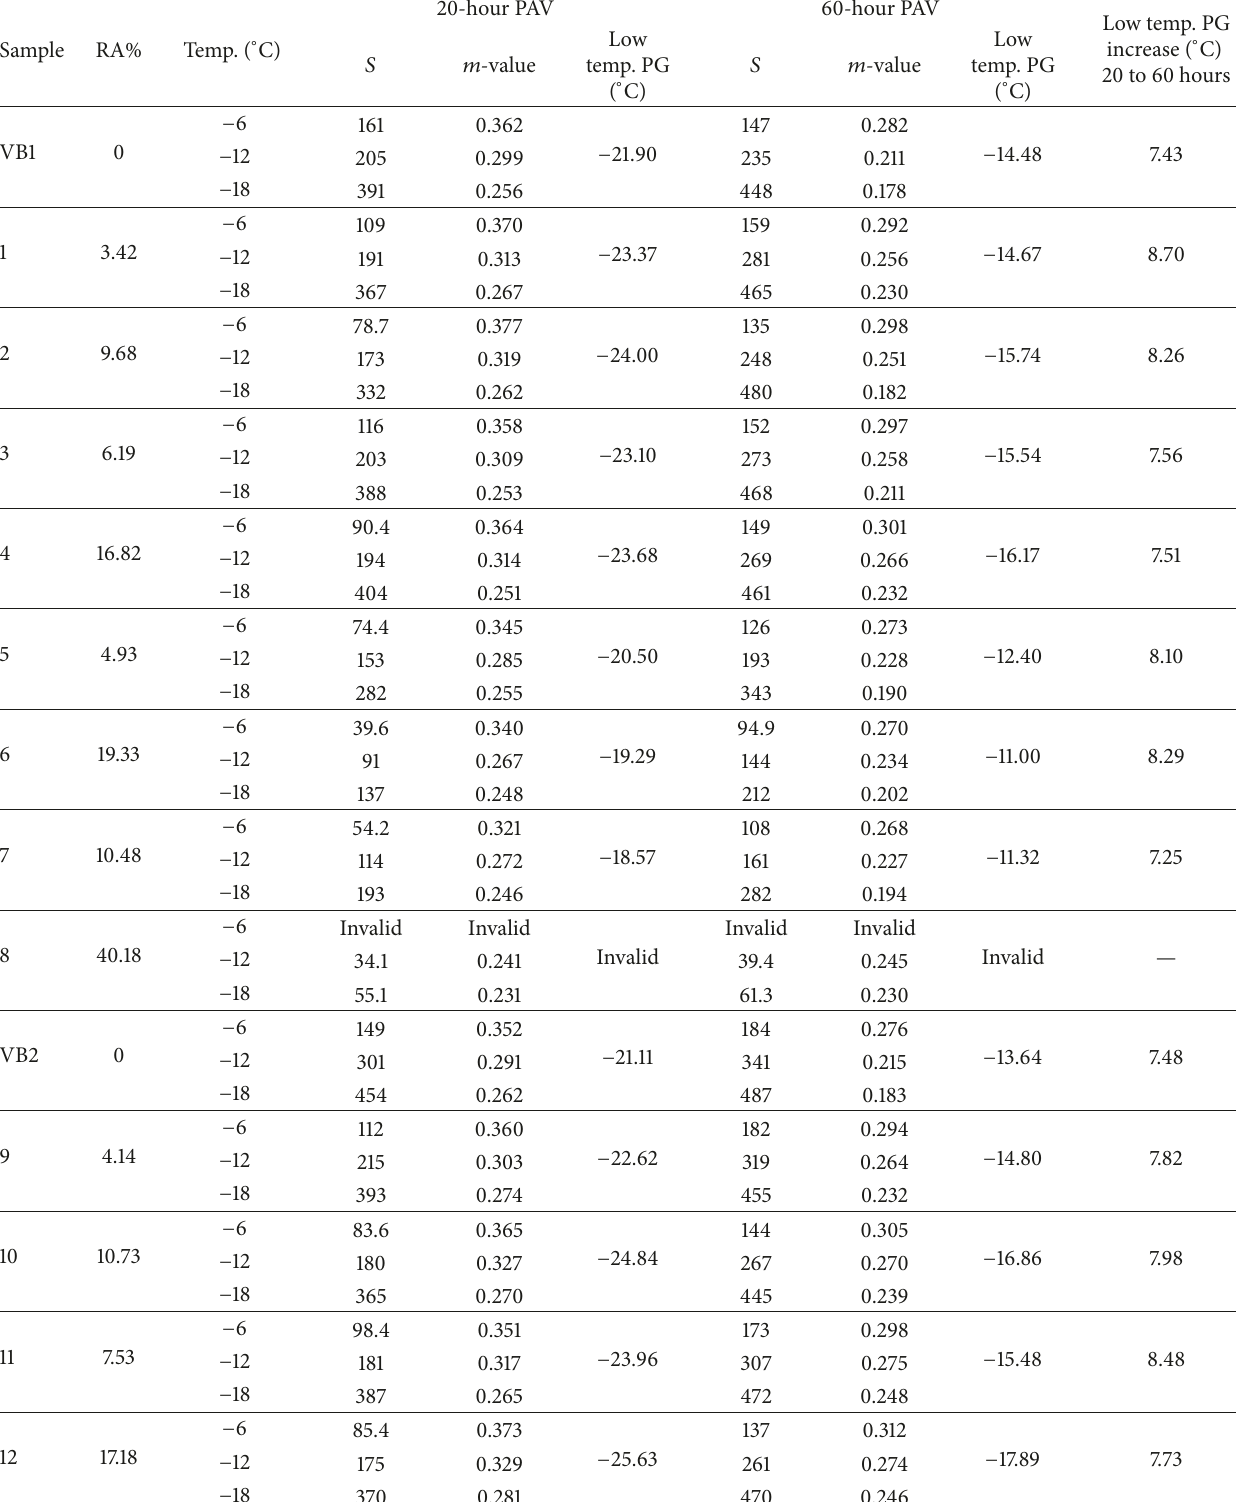
Table 6: BBR test for 20-hour PAV-aged